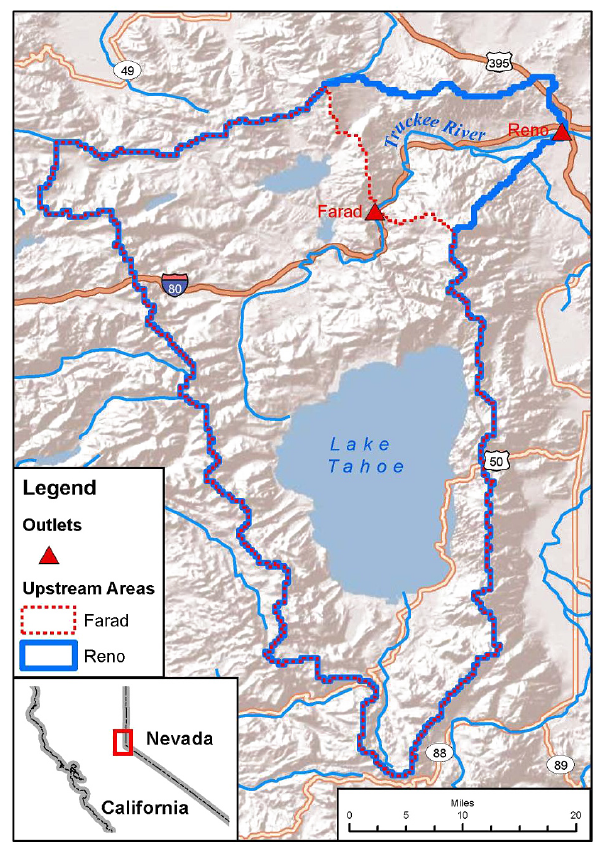
Figure 1. Map of model domain including the Farad and Reno gauges and their drainage